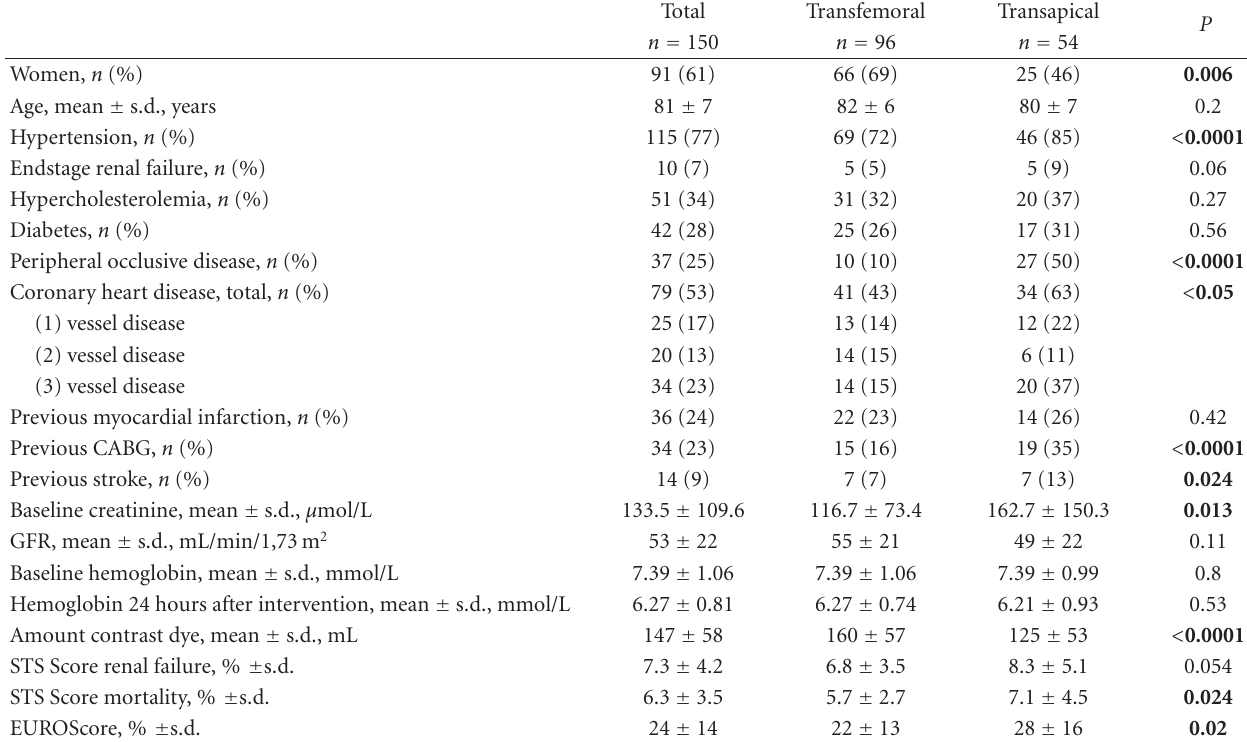
Table 1: Baseline data and periprocedural characteristics with respect to di ff erent access modes for valve